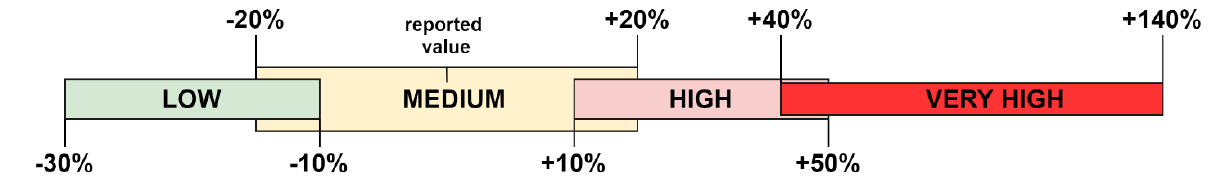
Figure 3. Adopted ranges for output cost.